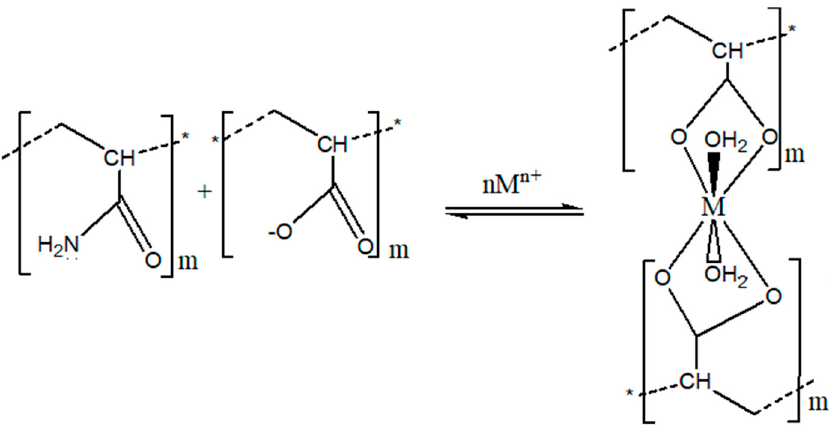
Figure 2. Proposed mechanism of PAM crosslinking through metal complexes formation.